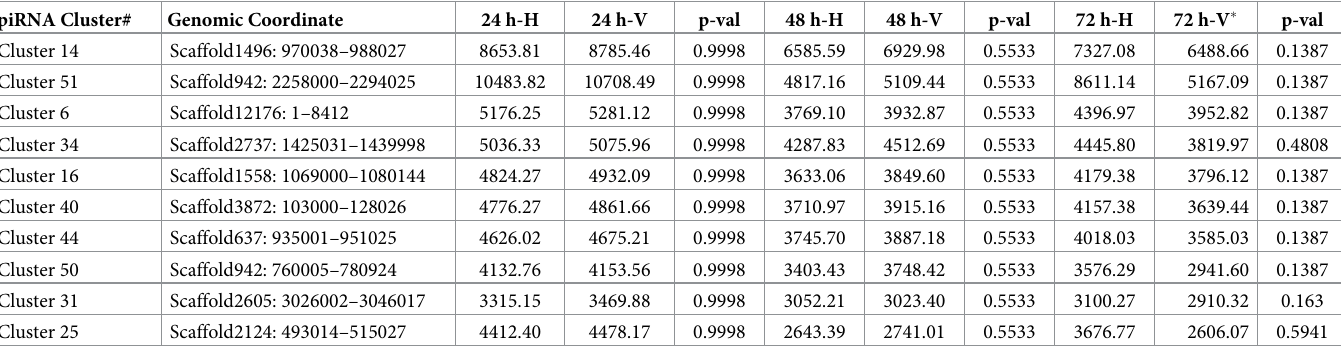
Table 3. Top 10 highly expressed piRNA clusters across three time